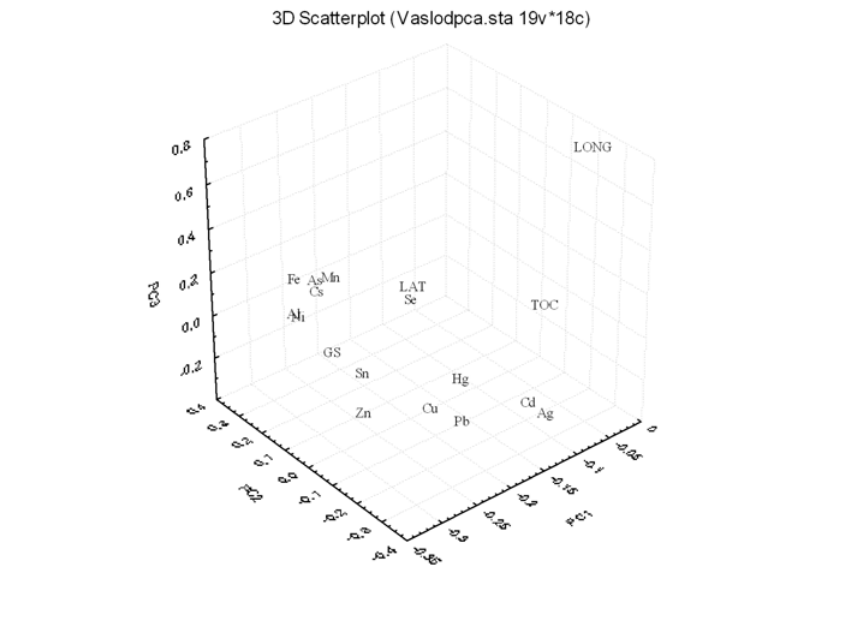
Fig. 1 Scatter plot of loadings corresponding to the first three principal components (classical PCA).